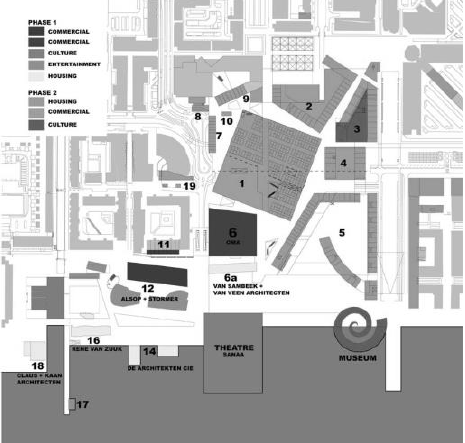
Figure 2. Almere master plan source: http:llwww.e-